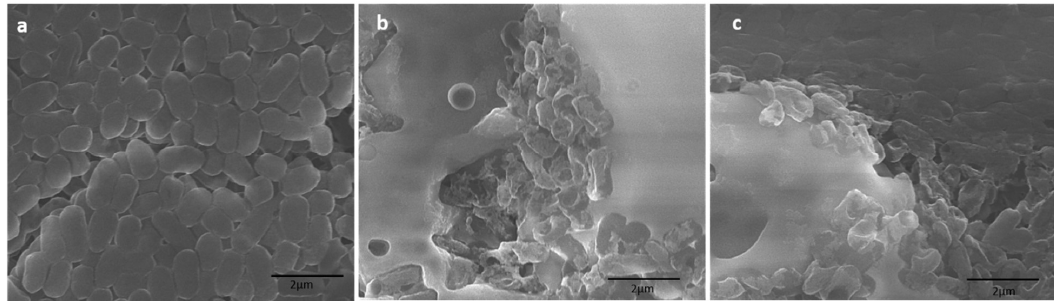
Figure 7. SEM micrographs of E. coli: ( a ) control (untreated cells); ( b ) Ag NPs at 100 µ g / mL; ( c ) TiO 2 NPs at 100 µ g / mL.